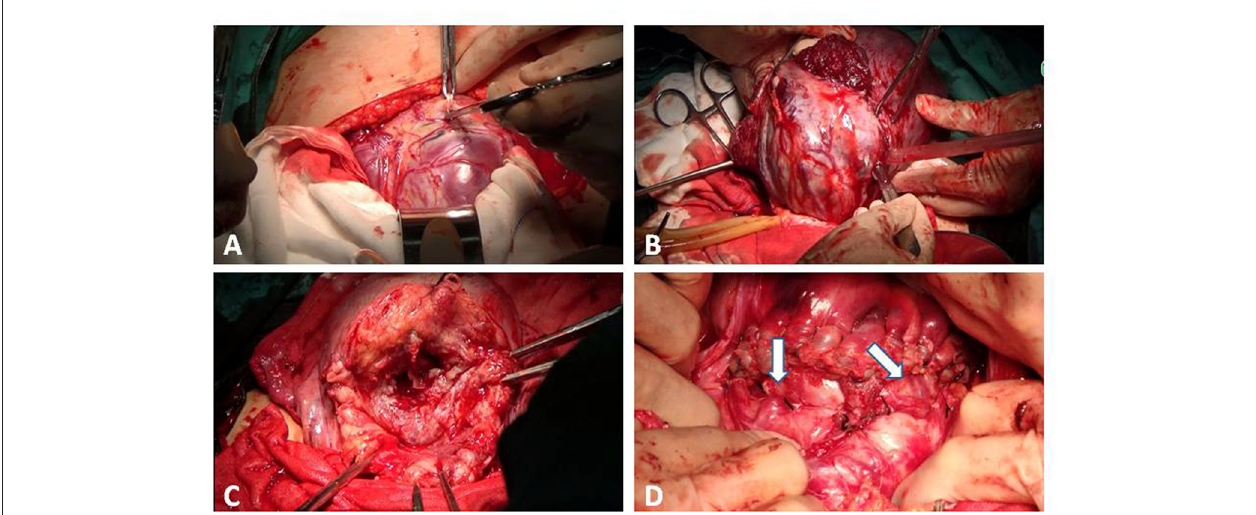
FIGURE 4 | Process of the procedure. (A) The uterine incision was over the upper border of the placenta. (B) A tourniquet was put as low as possible at the lower segment of the uterus. The bladder was pushed down and the anterior myometrium was partially resected with the placenta unseparated. (C) A single continuous suture was made along the lower lip of the uterine incision. (D) The lower transverse incision at the uterine was sutured in one layer. This area was still permeated with tortuous vessels (the arrow).